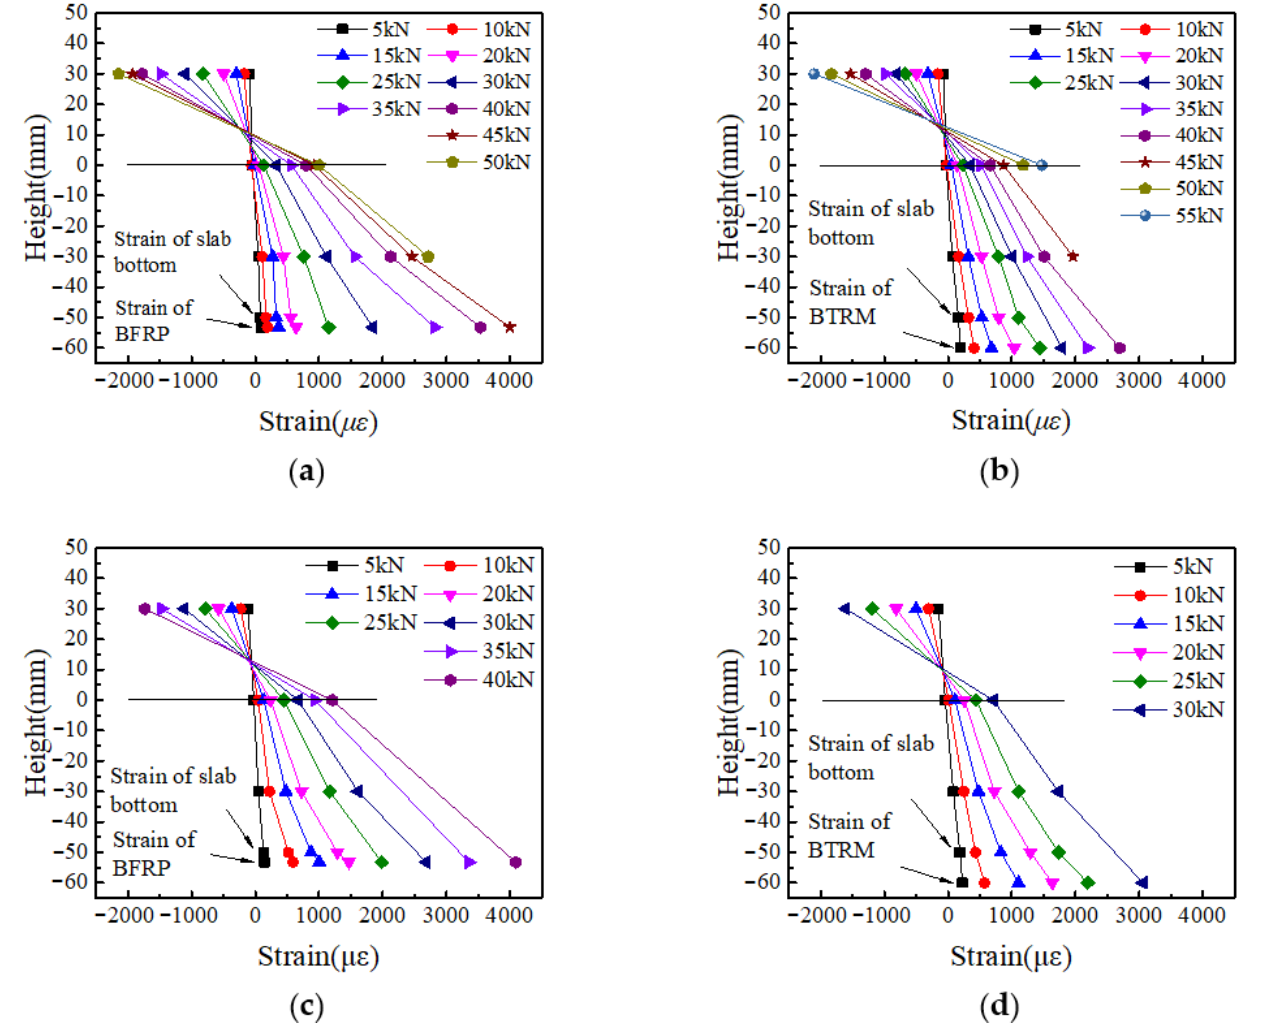
Figure 16. The strain distribution along the height of section: ( a ) M-P-5; ( b ) M-M-5;( c ) S-P-5;( d ) S-M-5.